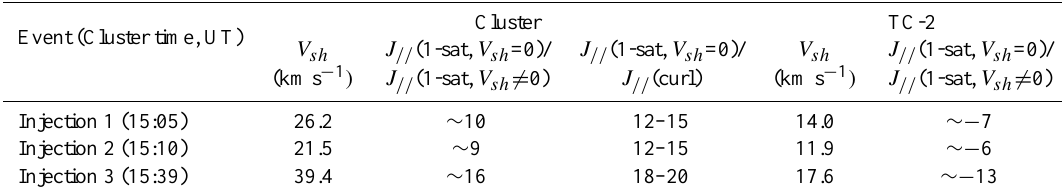
Table 3. Velocities of the injections at Cluster and TC-2, ratio between FACs calculated without and with sheet velocity and ratio between FACs calculated without sheet velocity and from the